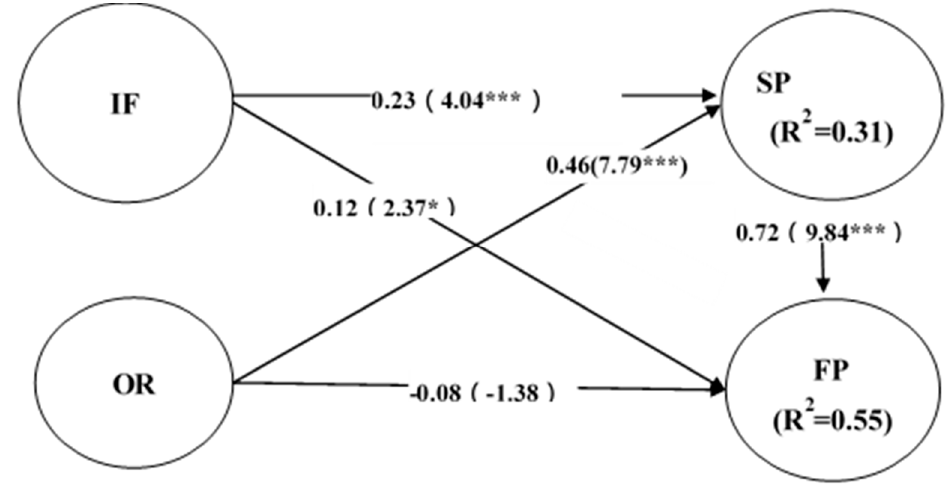
Figure 2. Direct e ff ect analysis; *** p < 0.001; * p < 0.01. Figure 2. Direct effect analysis; *** p <.001; * p <.01.